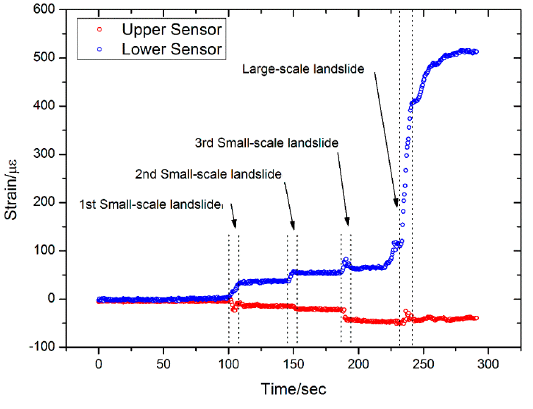
Figure 15. Results from Sensor 3.